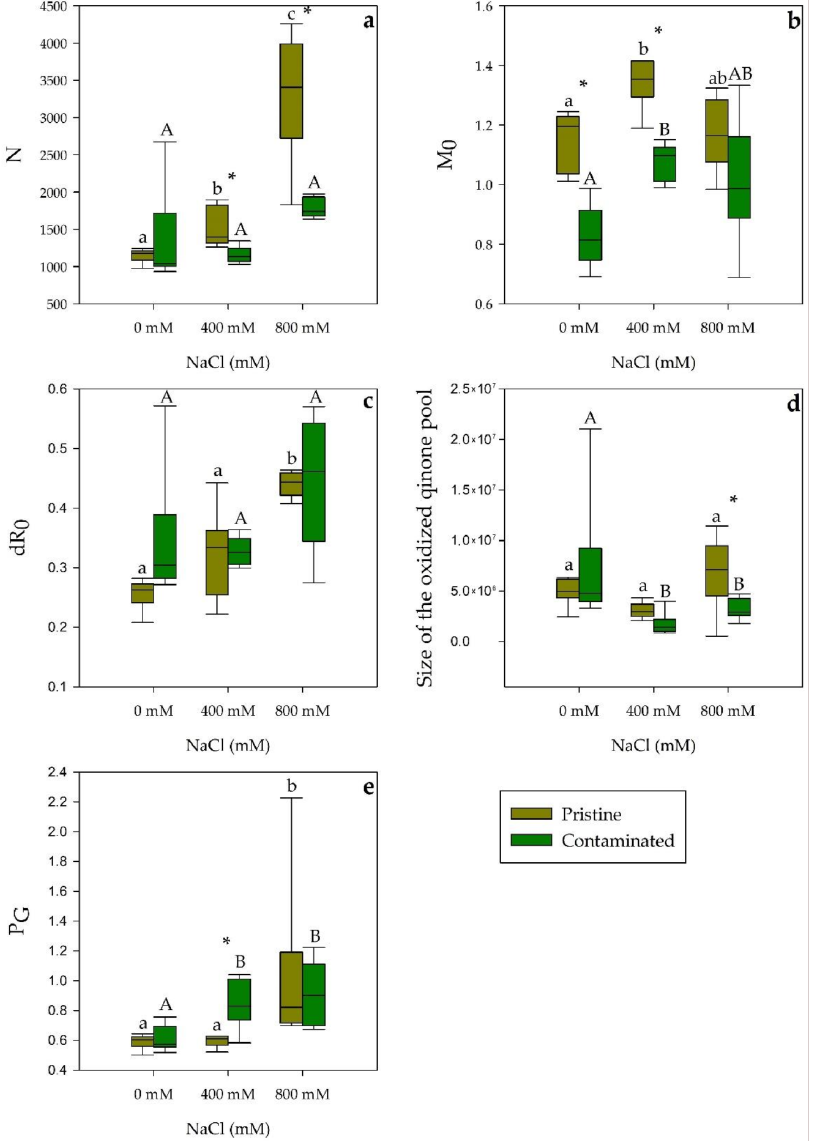
Figure 3. OJIP derived parameters, ( a ) the total number of electrons transferred into the electron transport chain (N), ( b ) the net rate of PS II reaction centers closure (M 0 ), ( c ) PS I efficiency in reducing its electron acceptors ( δ R 0 ), ( d ) size of the oxidized quinone pool, and ( e ) grouping probability (P G ) in S. patens dark-adapted leaves from pristine and heavy metal contaminated sites (average ± standard error, N = 5), along with the tested NaCl concentrations. Letters indicate significant differences between treatments at p < 0.05; asterisks mark significant differences between populations at p <